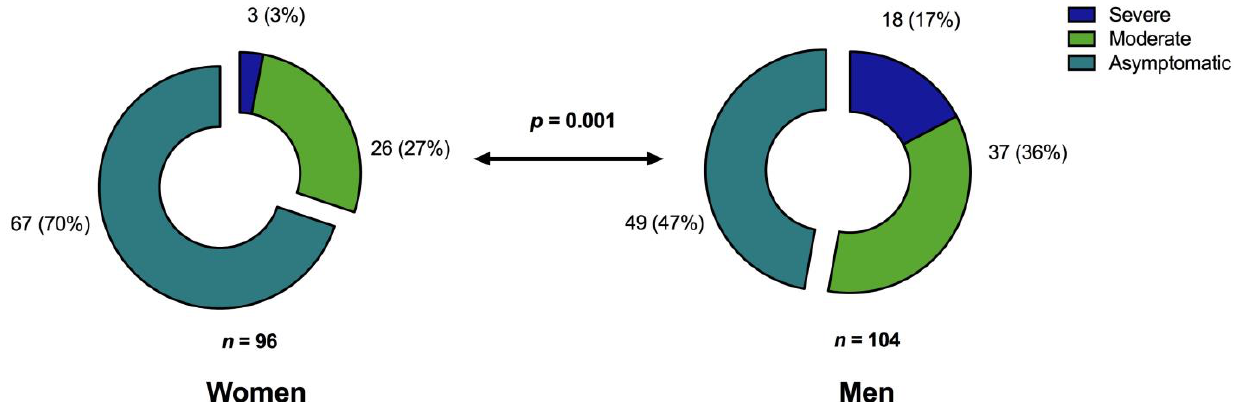
Figure 1. Proportion of COVID-19 severity levels in relation to patient sex [ n (%)]. Chi-square ( χ 2) test for trend indicated that men experience significantly more severe COVID-19 than women ( p = 0.001) according to the clinical classification of severity.